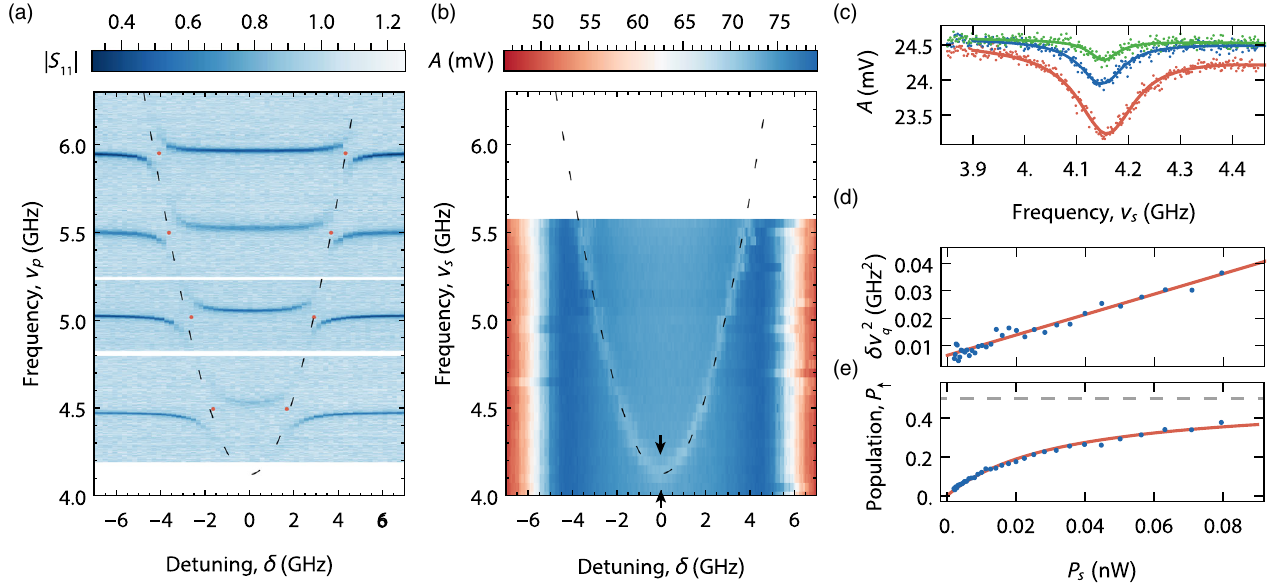
FIG. 4. DQD charge qubit spectroscopy. (a) Resonator reflectance spectra j S 11 j as a function of probe frequency ν δ for a set of four independent measurements taken at ν extracted from the data. The dashed line indicates the calculated transition frequency of the charge qubit. (b) Amplitude A of fixed frequency measurement tone ν dashed line indicates the expected qubit resonance frequency for 2 t ¼ 4 . 13 GHz. (c) Qubit line shapes A ð ν [arrows in (b)] for drive strengths P extracting the full width at half maximum (FWHM) of the line δν at the generator. (d) Extracted qubit linewidth δν 2 of qubit population with spectroscopy drive power P